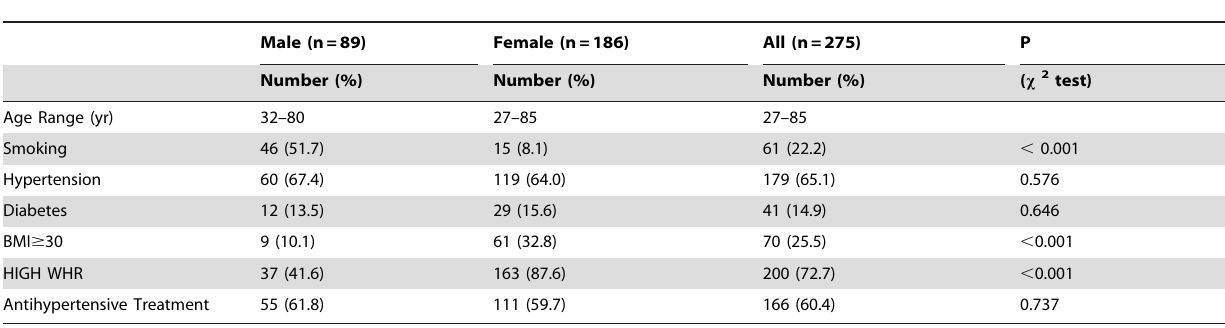
x 2 = Pearson chi squared test. P = statistical significance of